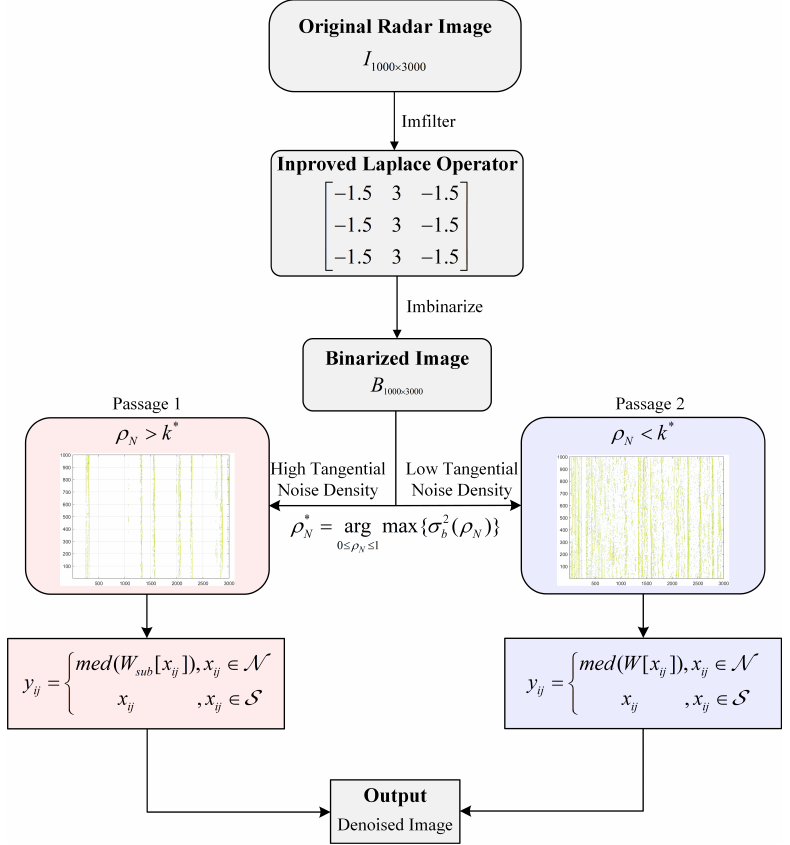
Figure 3. Flowchart of the improved adaptive median filtering